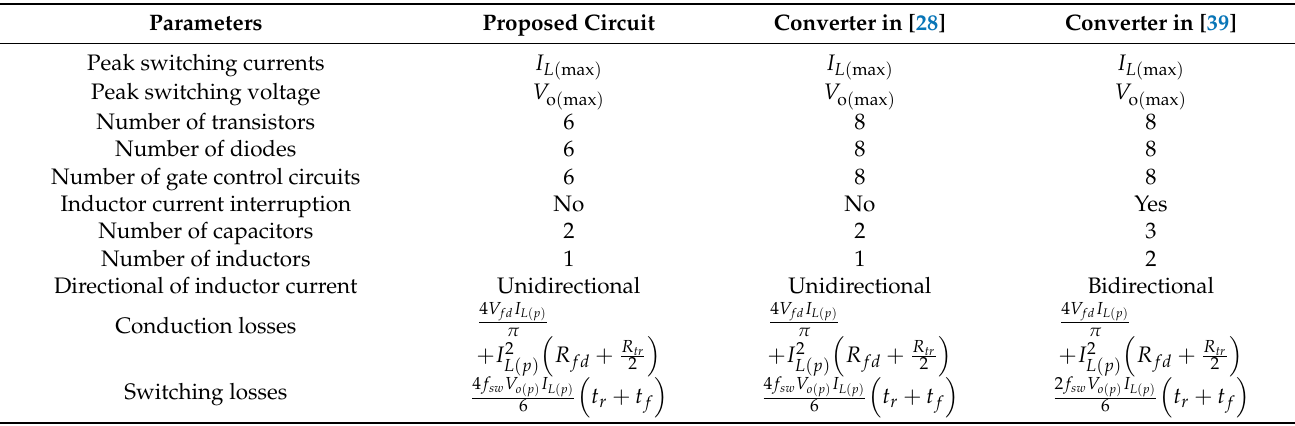
Table 1. Comparison with existing circuit